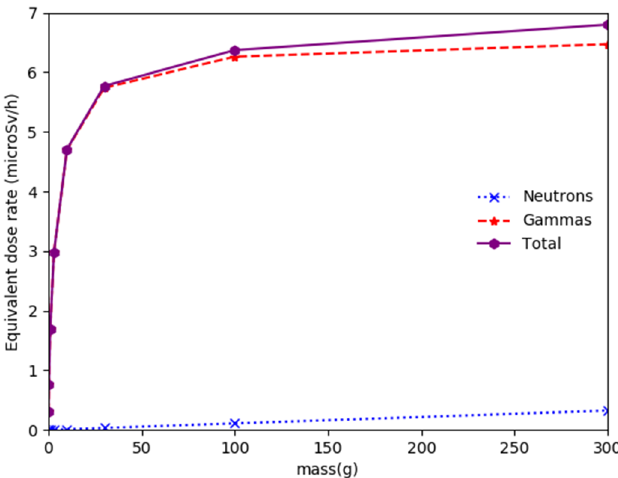
Fig. 6. Homogeneous model, Corner source with parametrical variation of the density, results right over